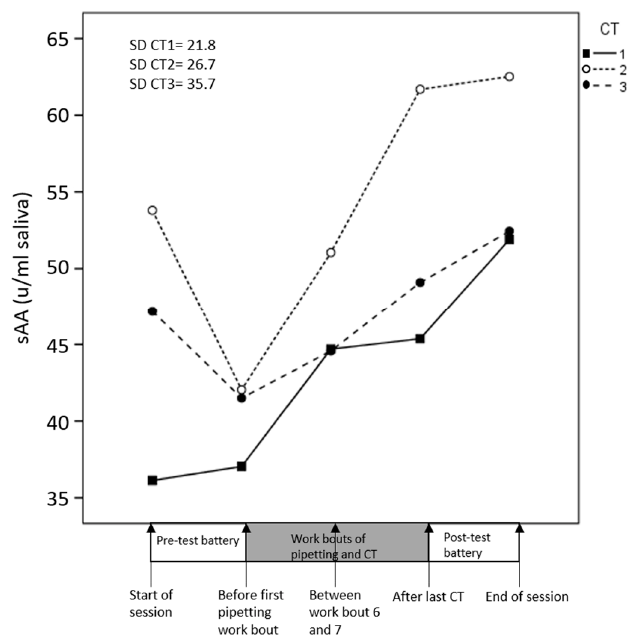
Figure 7. Salivary alpha-amylase (sAA) during the experimental session. Separate lines illustrate the the three cognitive task (CT) di ffi culties. Standard deviations (SD) refer to all participants and all three cognitive task (CT) difficulties. Standard deviations (SD) refer to all participants and all time points. time